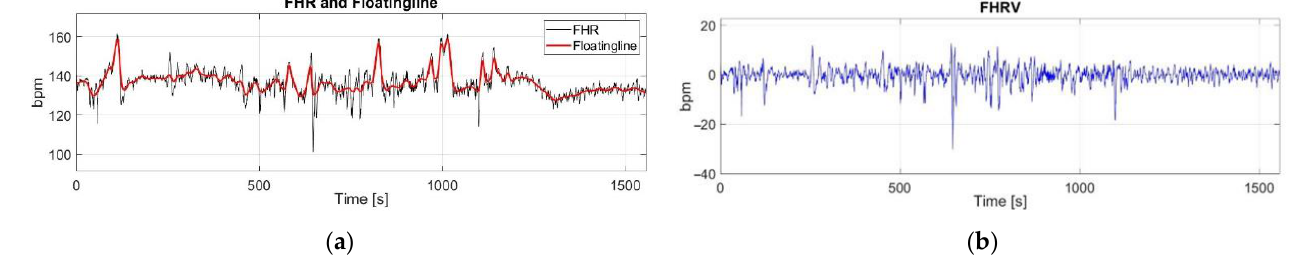
Figure 3. FHRV estimation: ( a ) FHR signal with floatingline (superimposed in red); ( b ) estimated FHRV.